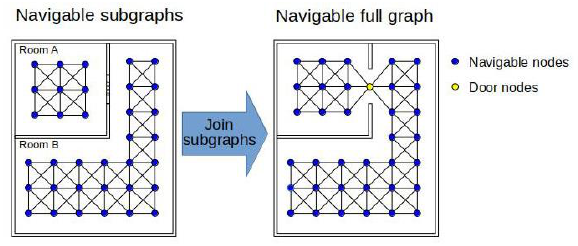
Figure 9. Building elements are organized in layers according to semantics. Figure 7. Graph creation in case of a) absence of rooms, b) presence of rooms. The distribution of candidate positions (in grey) is shown in Figure 10. In this case, the distribution of the navigable space is carried out using a grid-based approach with a regular resolution of 0.5 m. Considering a maximum range of acquisition of 5 m, a visibility analysis is performed for all candidate positions. Afterwards, optimization is carried out taking into account a 90% of coverage as stop condition. As a result, 699 candidate positions are analysed and a total of 17 scan positions (in red) is obtained (Figure 10). The processing time was 82.9